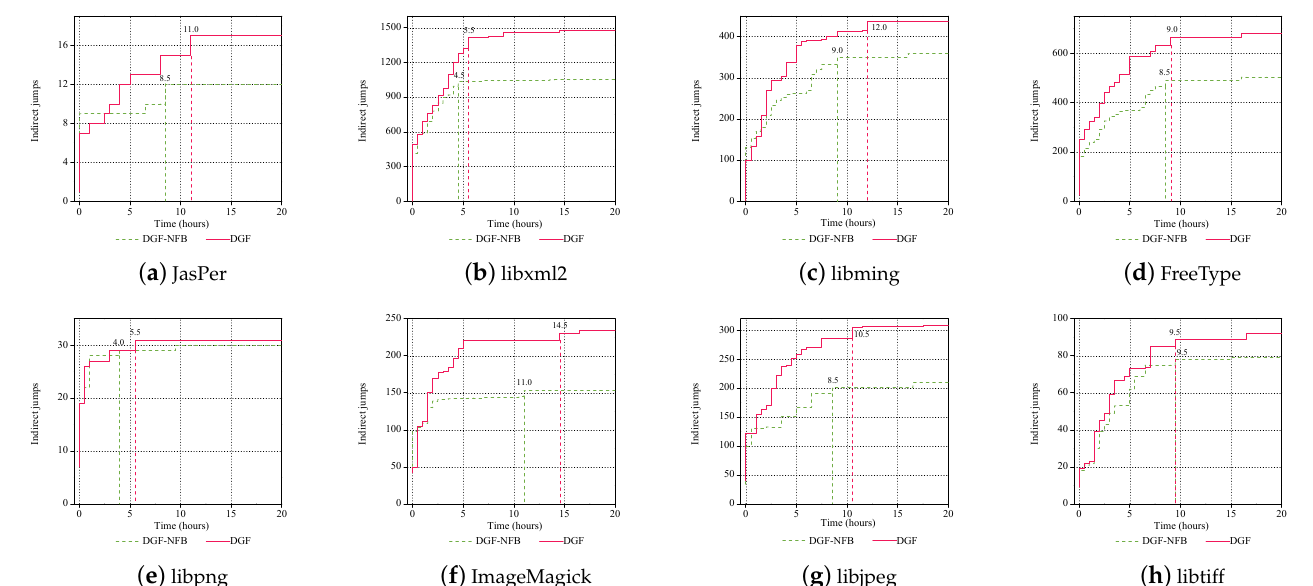
Figure 9. The number of indirect jumps resolved by two approaches on 8 benchmarks. The red bar (DGF) represents our approach with iterative feedback, and the green bar (DGF-NFB) is the opposite. The vertical line represents the stuck time of the corresponding approach.